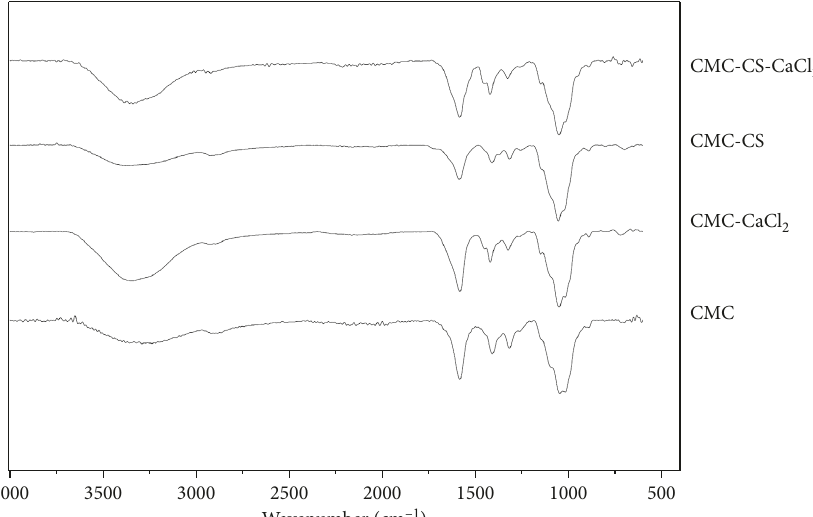
Figure 10: FTIR Spectra of hydrogels made from CMC (a) 2% by (b) ionotropic gelation with CaCl plexation with CS 0.01% w/v, and (d) combination of ionotropic gelation and polyelectrolyte complexation mixing.